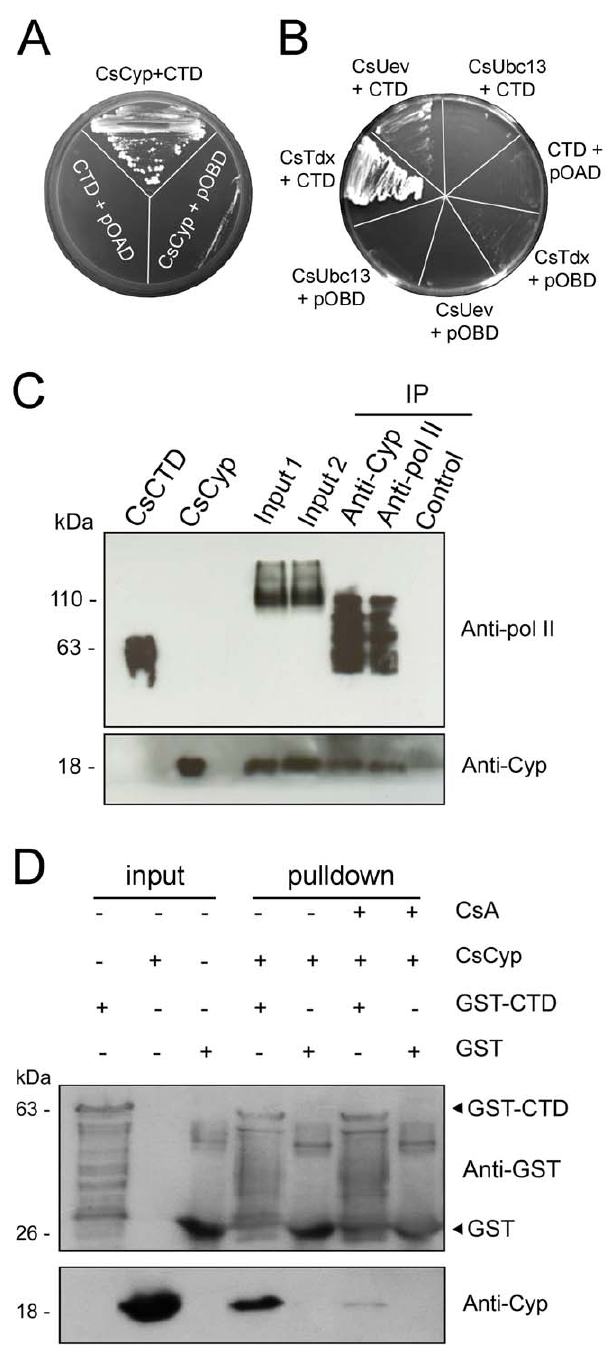
Figure 2. Interactions of the CTD of the citrus RNA polymerase II with CsCyp. (A) Yeast two-hybrid assay showing the interaction between CsCyp (pOAD-CsCyp) and the C. sinensis CTD (pOBD-CTD). Control yeast cells co-transformed with the bait (pOBD-CTD) plus empty pOAD or the prey (pOAD-CsCyp) plus empty pOBD are indicated. (B) Yeast two-hybrid assay showing interactions between the CTD with CsTdx (pOAD-CsTdx) and CsUev (pOAD-CsUev), but not CsUbc13 (pOAD-CsUbc13). Yeast cells were co-transformed with the bait plus empty pOAD (CTD + pOAD) or the preys CsTdx, CsUev, CsUbc13 plus empty pOBD as controls. (C) Western blot of immunoprecipitation (IP) reactions showing that the anti-human RNA pol II (anti-pol II) cross- reacted with the recombinant citrus CTD (CsCTD) and with proteins from the citrus cell extracts treated with DNase I (Input 1) or not (Input 2), including a major band of , 110 kDa. The anti-pol II serum detected